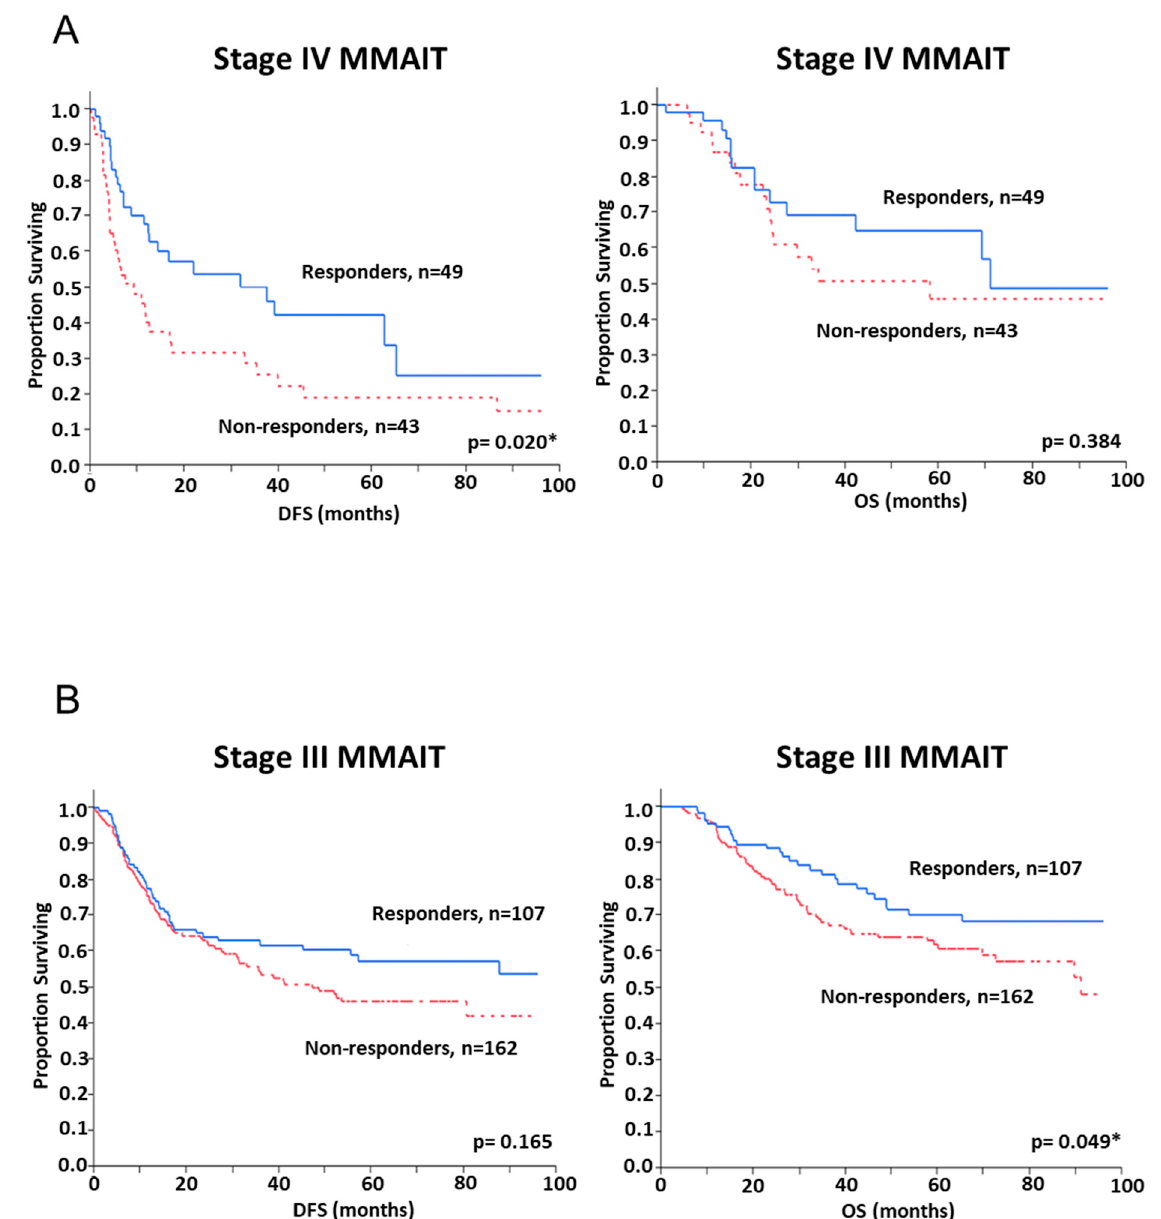
Figure 5. Kaplan Meier survival curves of patient groups defined by the gene SNP panel. Patients were classified into “responders” and “non-responders” by their SNP score found on the gene SNP panel. Kaplan-Meier survival curves were constructed for these two groups. ( A ) In the pilot cohort of stage IV MMAIT patients ( n = 92), there was a significant difference in DFS between responders and non-responders ( p = 0.020). ( B ) In the verification cohort of stage III MMAIT patients ( n = 269), responders had an improved OS ( p = 0.049). DFS = disease-free survival, OS = overall survival, MMAIT = Malignant Melanoma Active Immunotherapy Trial. * p < 0.05.